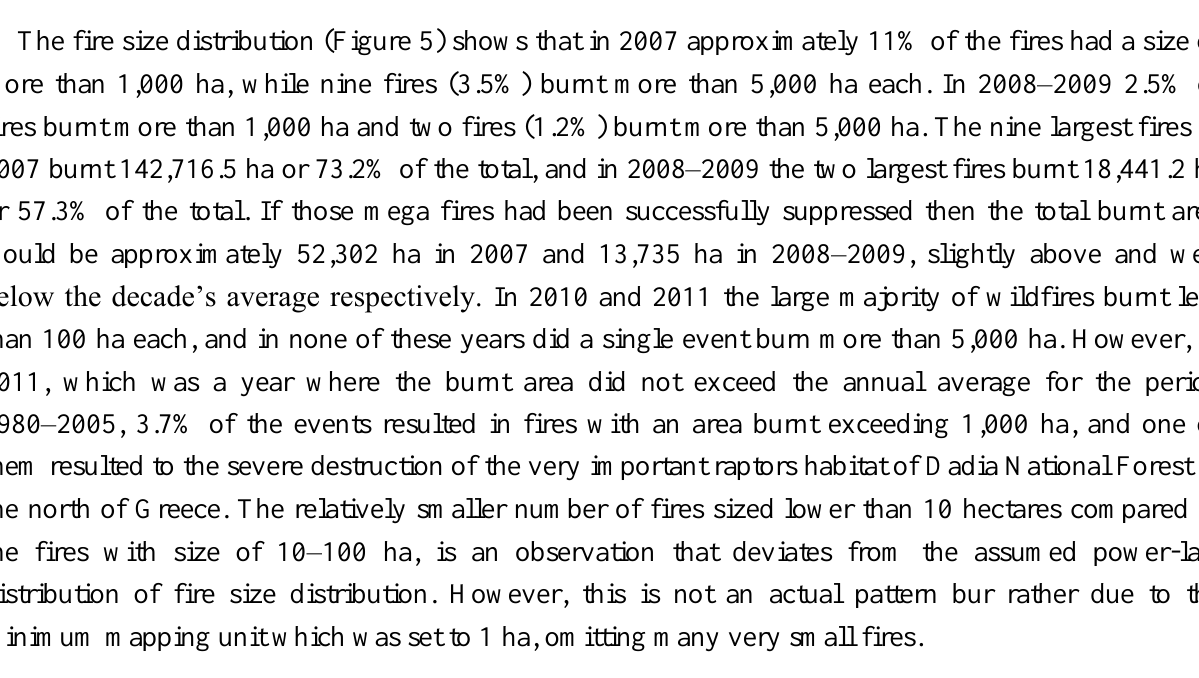
Figure 5. Fire size distribution for the studied fire seasons